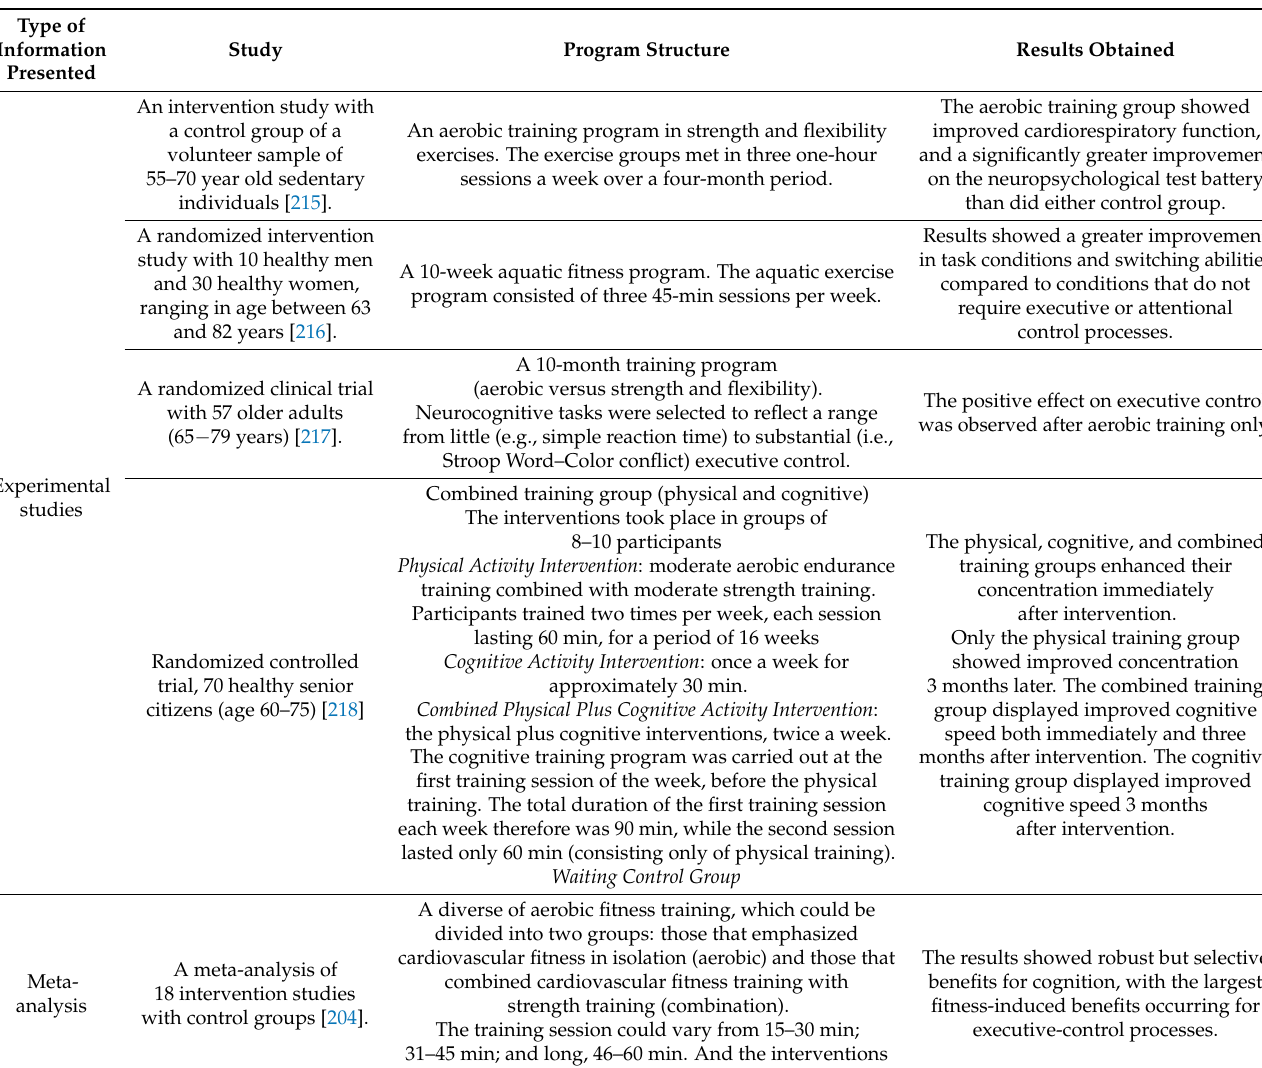
Table 4. Examples of experimental/program evaluation and meta-analyses studies of regular physical activity and exercise for enhancing and promoting cognitive